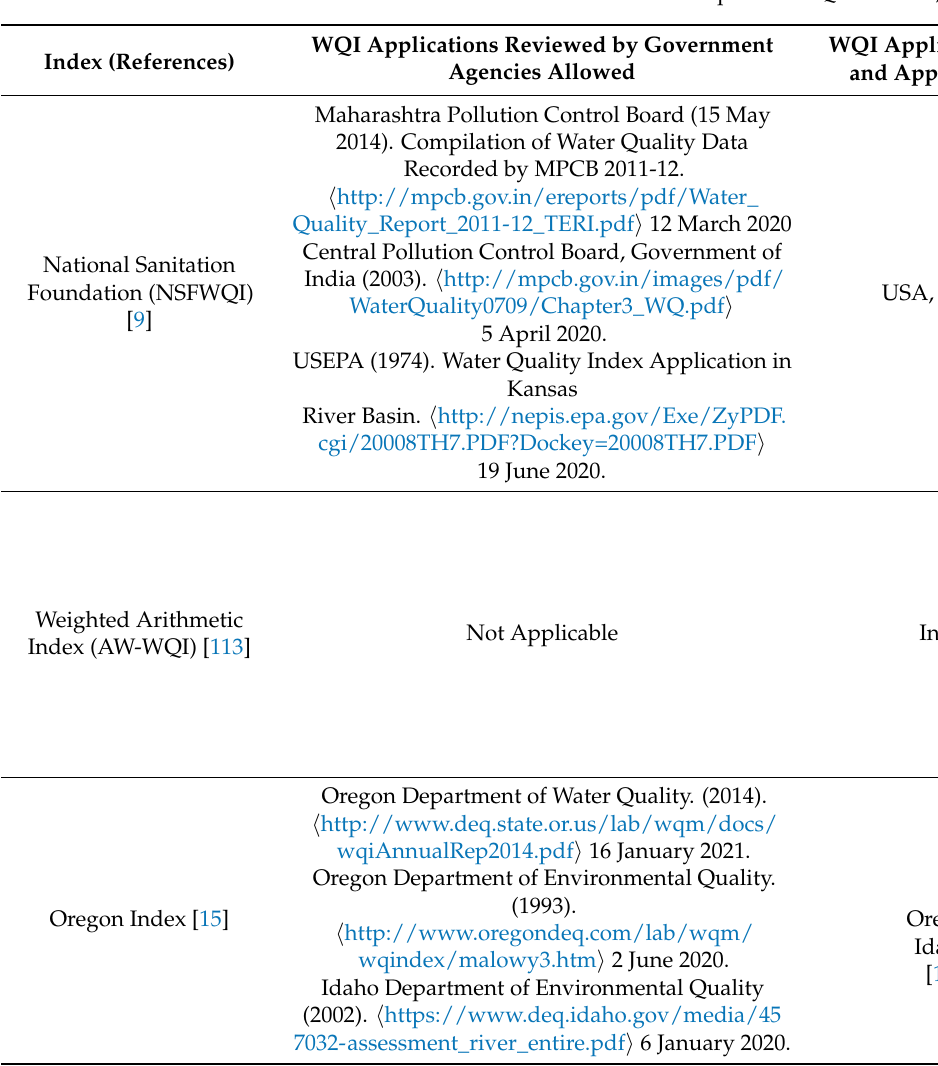
Table 4. Numerous important WQI methods, their application, advantages and